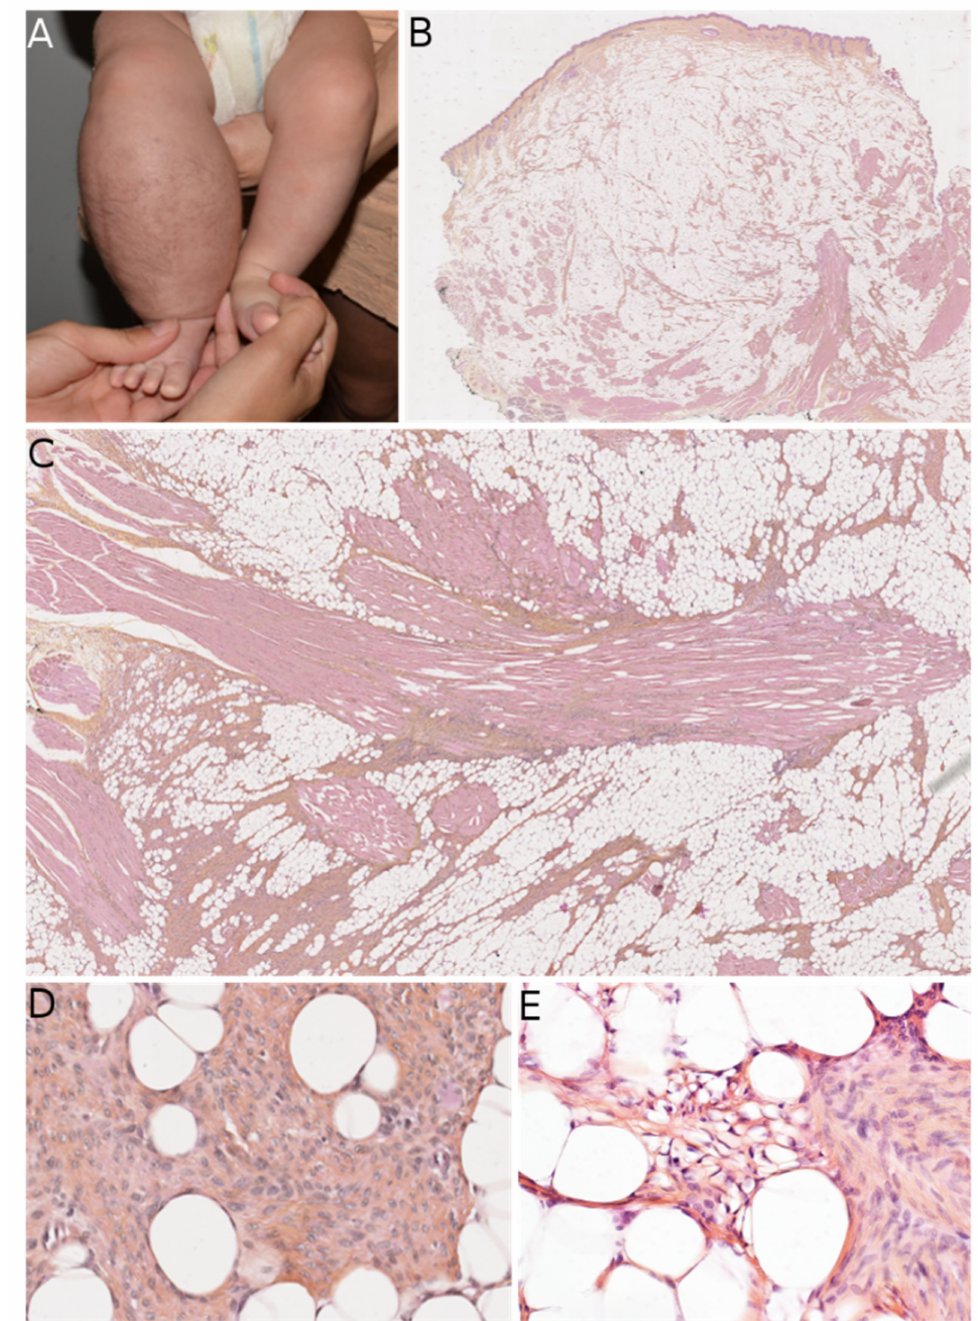
Figure 4. Lipofibromatosis (LPF). ( A ) Clinical presentation as a large mass of the right lower leg in an infant (courtesy of the Department of Maxillofacial Surgery, Necker-Enfants Malades hospital, Paris, France). ( B ) Low-power view of the lesion showing location in the subcutis (HES × 50). ( C ) Long fascicles of spindle cells admixed with adipose tissue (HES × 100). ( D ) High-power view showing the bland morphology of the cells (HES × 200). ( E ) Focus on cells with a single vacuole at the interface between the fibroblastic and the adipose components (HES ×